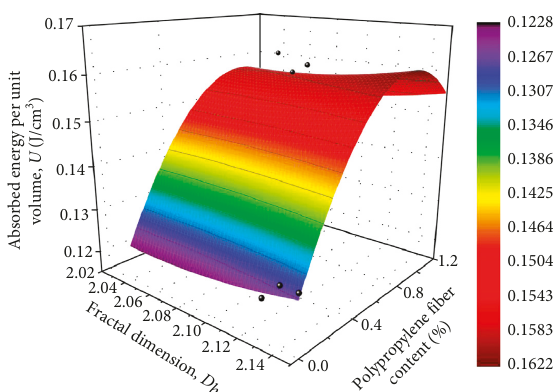
Figure 15: Relationship of absorbed energy per unit volume with fractal dimension and polypropylene fiber per unit volume has a quadratic parabola relationship with the fractal dimension value through the curve fitting.